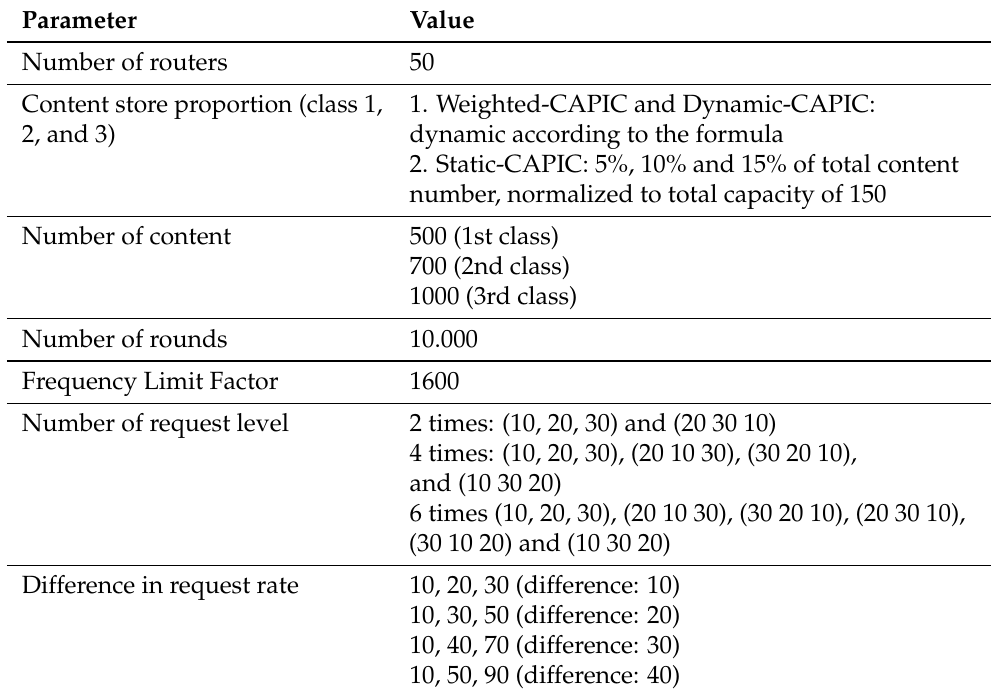
Table 2. Simulation